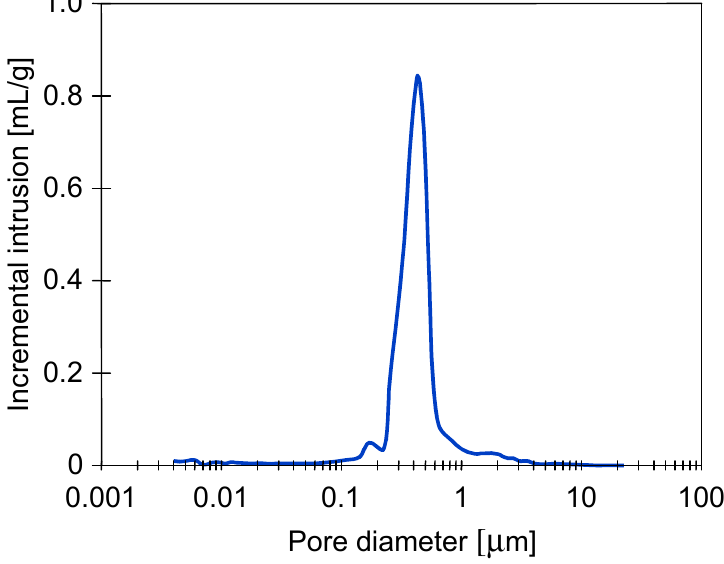
Figure 4. Mercury intrusion porosimetry.